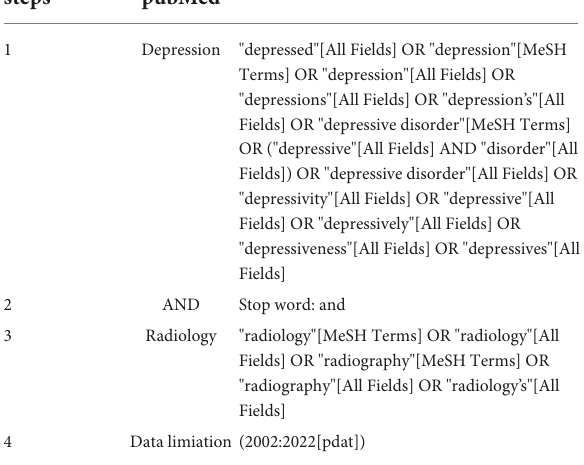
TABLE 1 Major depressive disorder (MDD) and radiology publications assortment steps. Exploration